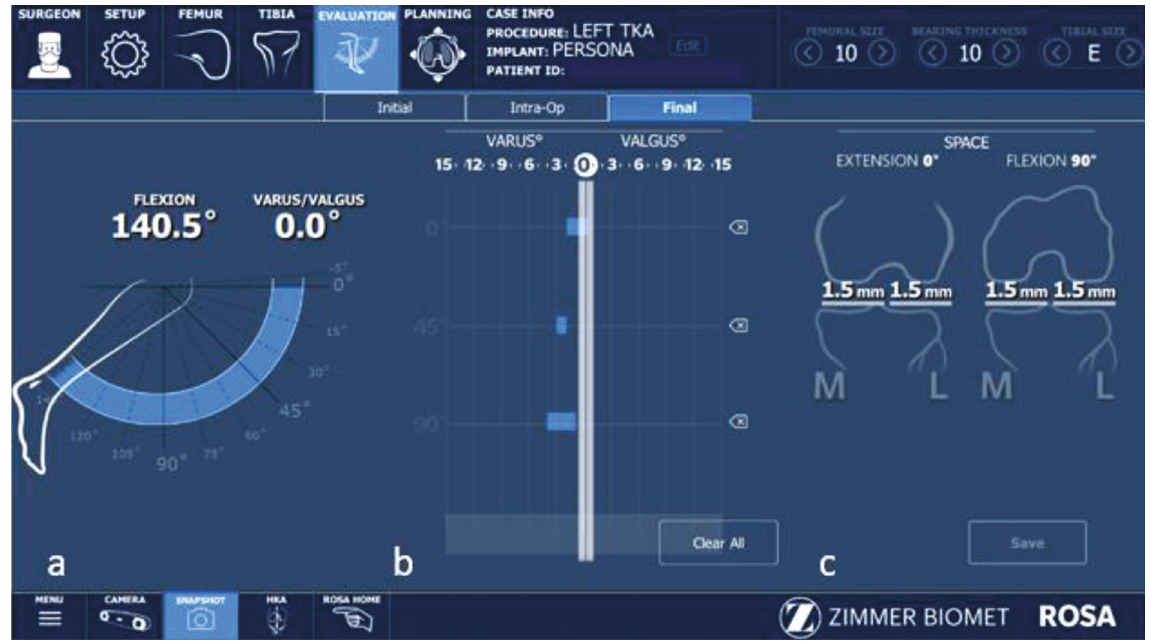
Figure 21: Final ROSA evaluation following TKA for Case 5 including (a) ROM, (b) alignment, and (c) joint space evaluation.